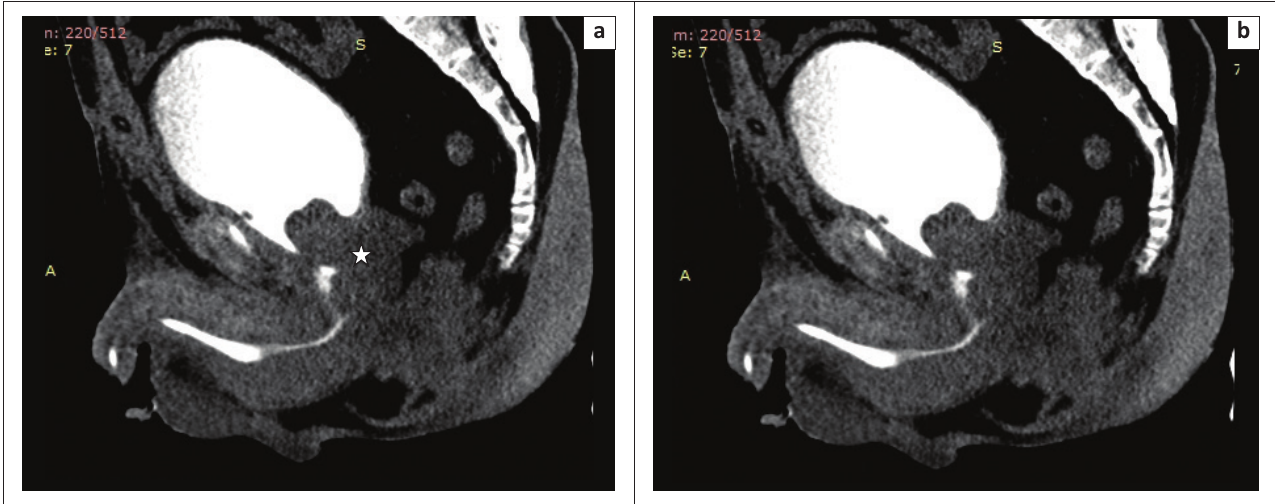
FIG URE 16: Multidetector computed tomographic urethrography: Sagittal multiplanar reformatted image showing prostatomegaly (star), with the median lobe seen bulging into the bladder base and compressing the posterior urethra, creating a false impression of a posterior urethral